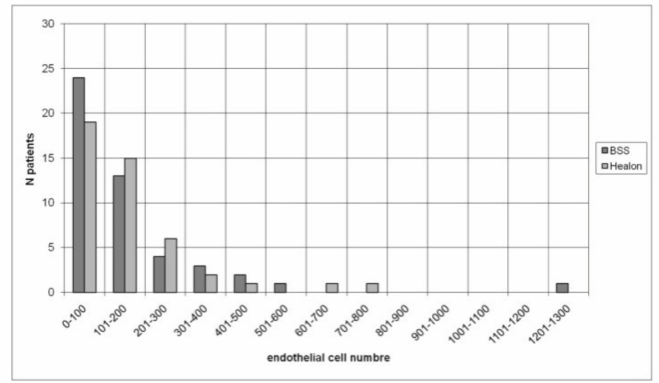
Figure 12. Number of patients via endothelial cell loss.